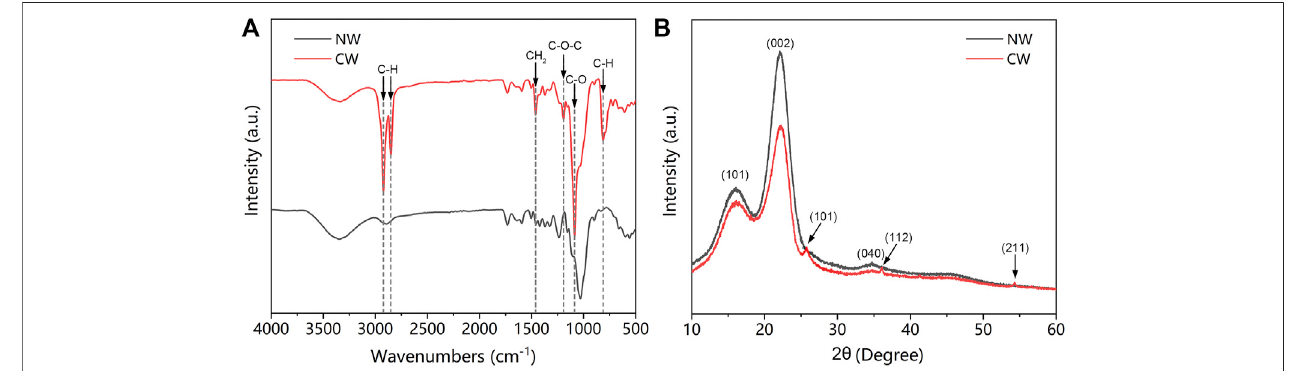
FIGURE 3 | Comparison of the chemical structure of NW and CW. (A) FT-IR spectra of the NW and CW. (B) XRD patterns of the NW and CW.